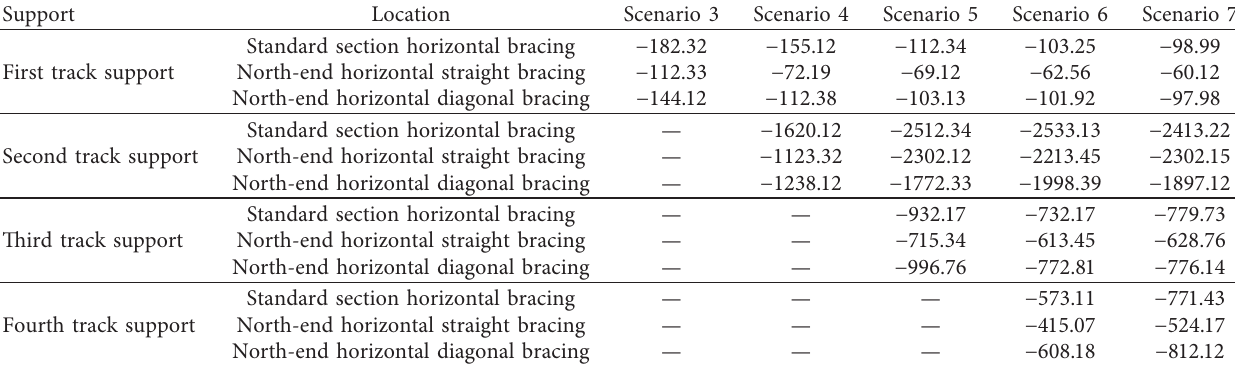
Table 5: The axial force of the internal support under each analysis